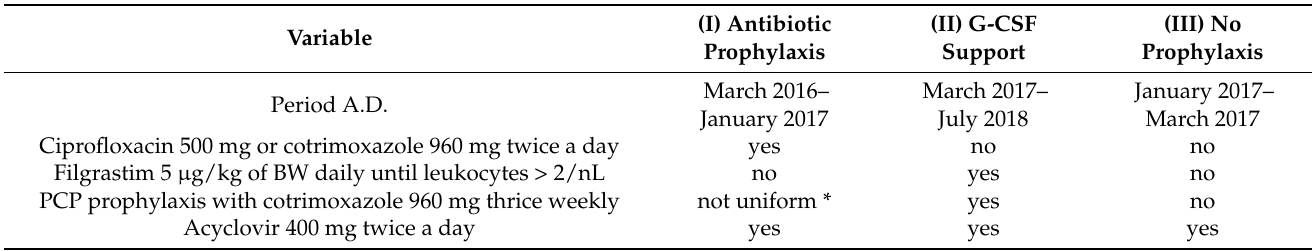
(I) Antibiotic Prophylaxis